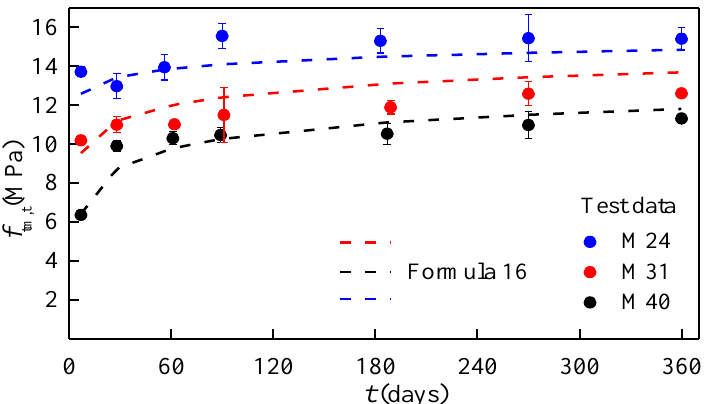
Figure 6. Comparison of calculated to test flexural strength of mortars at different curing ages.